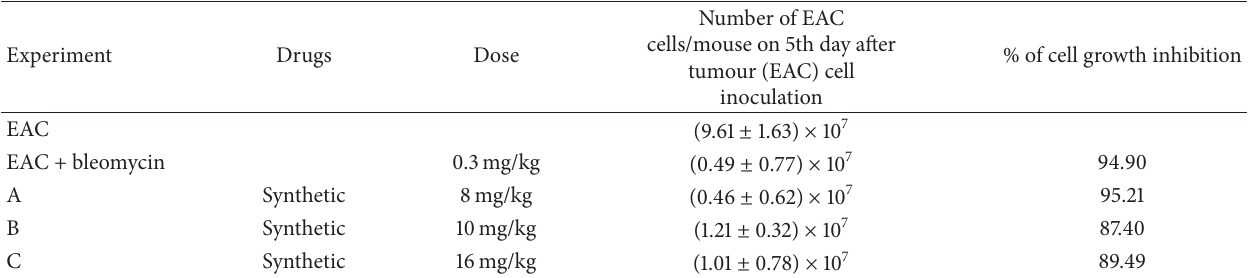
Table 4: The effect of test compounds and bleomycin on EAC cell growth inhibition.